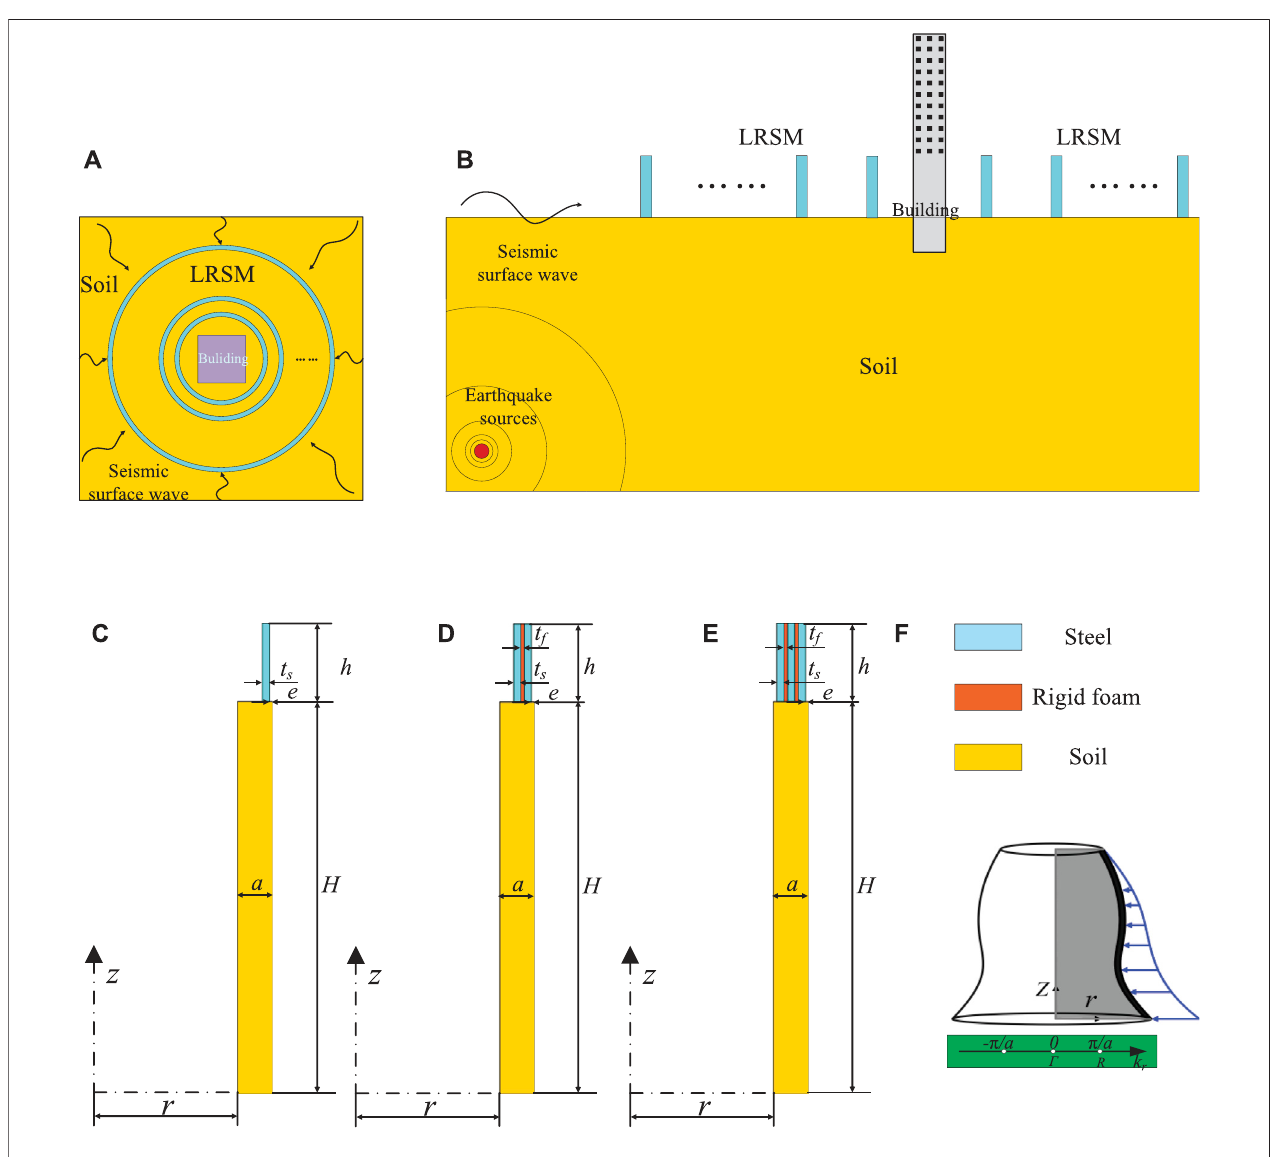
FIGURE1| Radialseismicmetamaterials: (A) and (B) radialseismicmetamaterialssurroundingimportantbuildings; (C) LRSM-1; (D) LRSM-2; (E) LRSM-3; (F) the formation mode of the radial seismic metamaterials and diagram of BZ wave vector (Gamma-R) in reciprocal space. The blue, orange and yellow represent steel, hard foam and soil, respectively.